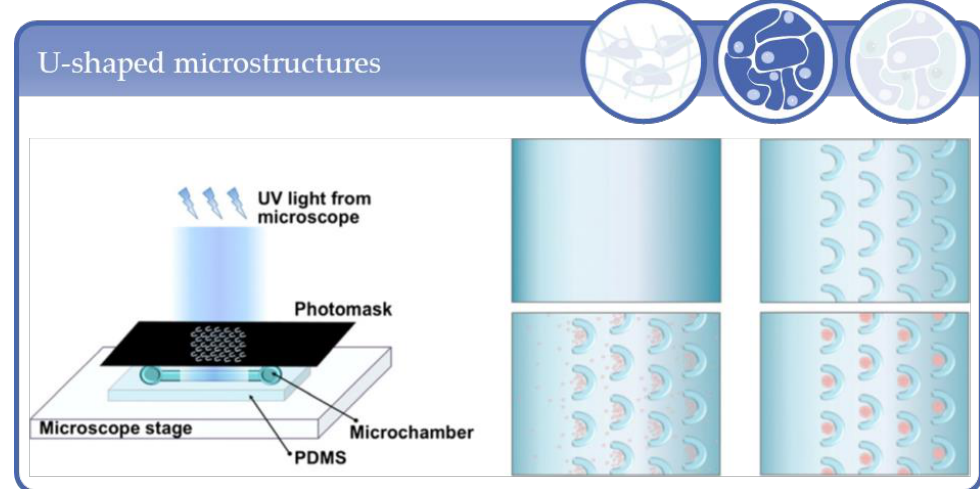
Figure 14. Flowchart of U-shaped microstructure fabrication, cell trapping, and spheroid formation. Reprinted from [127]; © IOP Publishing. Reproduced with permission. All rights reserved.